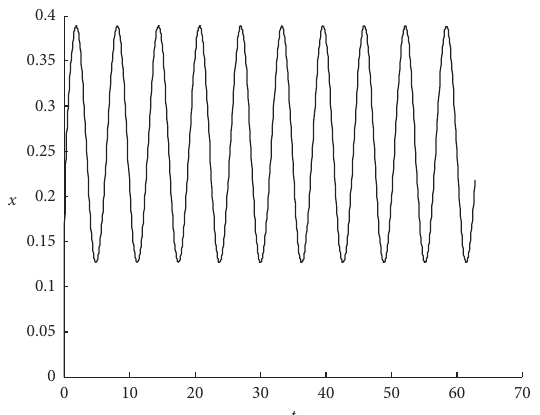
Figure 1: The solution curve of equation (51) with an initial value x ( 0 ) � 0.